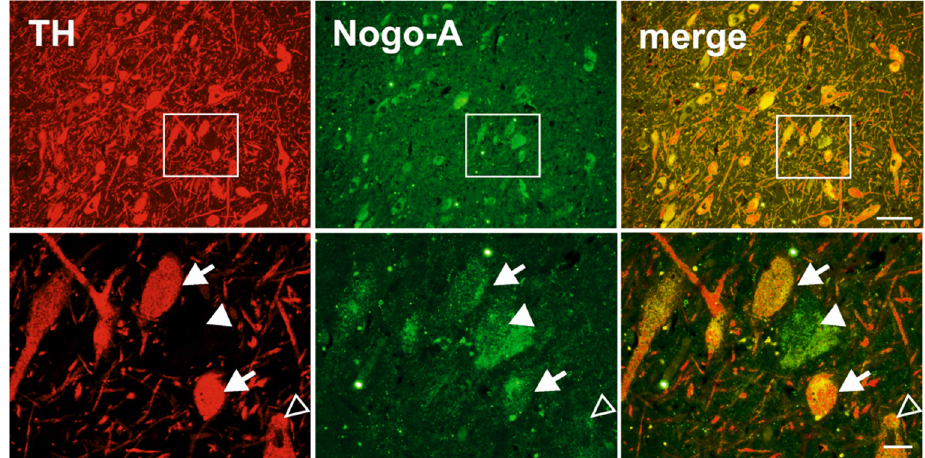
Figure A3. Representative digitalized photomicrographs of the human SNc stained for TH and Nogo-A. Lower panels show magnifications of boxed areas in the upper panels. Note some cells showed immunoreactivity for Nogo-A (arrowhead) or TH only (open arrowhead) while other neurons express both markers (arrows). Scale bars: 100 µm (top row), 20 µm (bottom row).